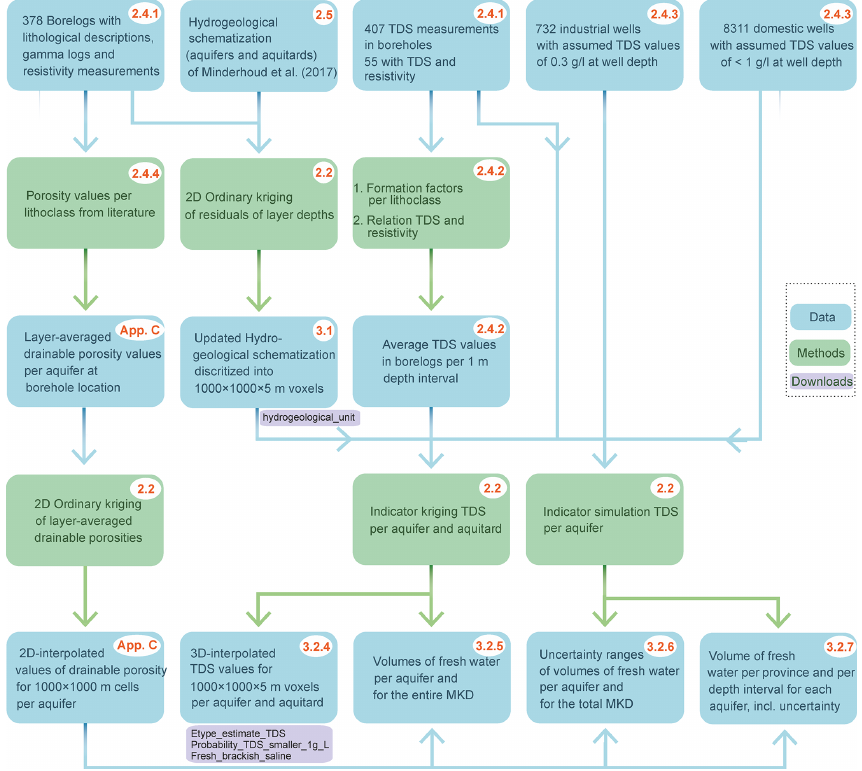
Figure 2. Workflow of assessing the 3D groundwater salinity distribution (in gL − 1 TDS) and the fresh groundwater volumes in the Mekong Delta, Vietnam. Red numbers provide sections and subsections where data and methods are described.